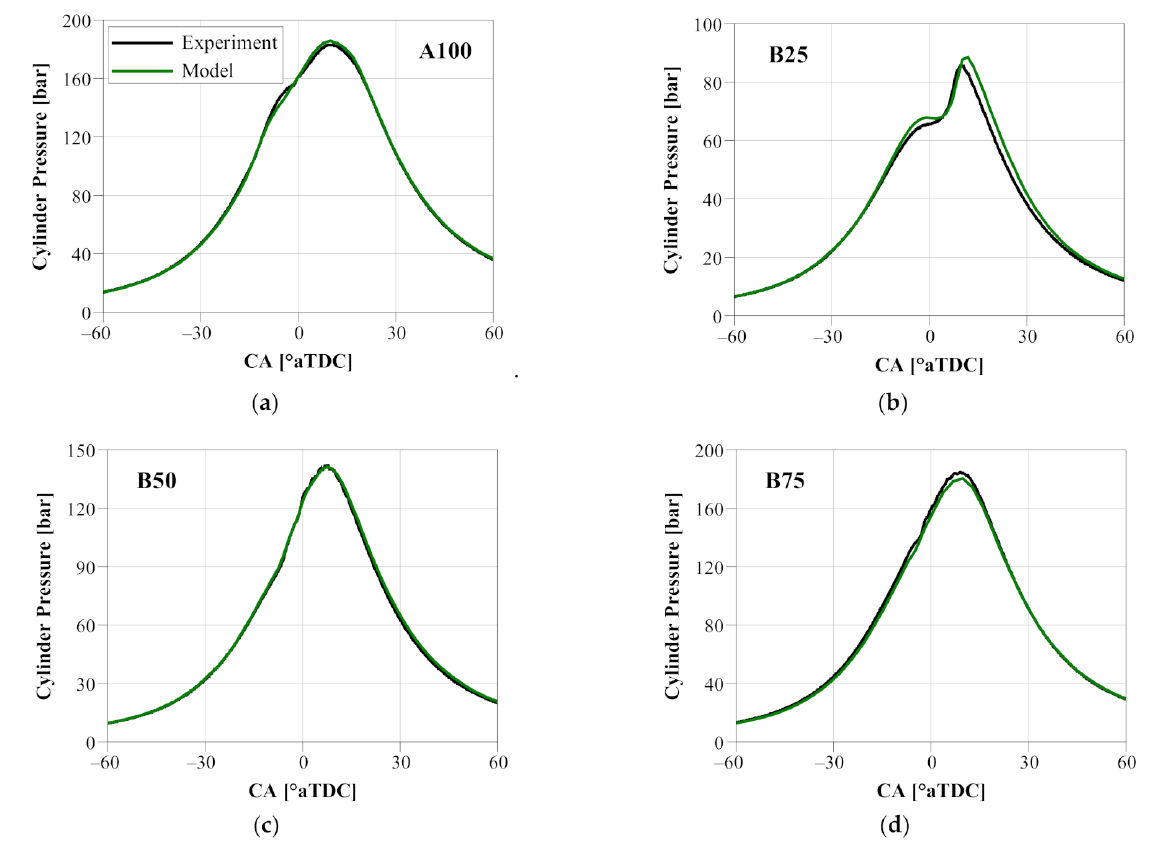
Figure 7. Experimental and simulated cylinder pressure for Gen1 GCI: ( a ) A100; ( b ) B25; ( c ) B50; ( d )